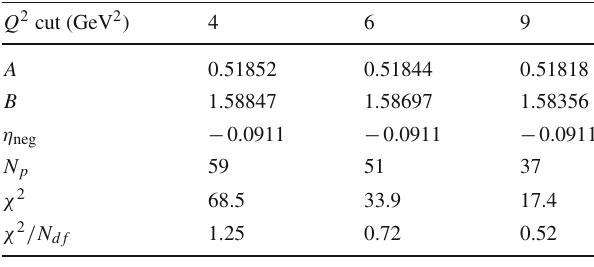
Table 4 Results of the AB fit with x < 0 . 001 and b = 10 GeV − 2